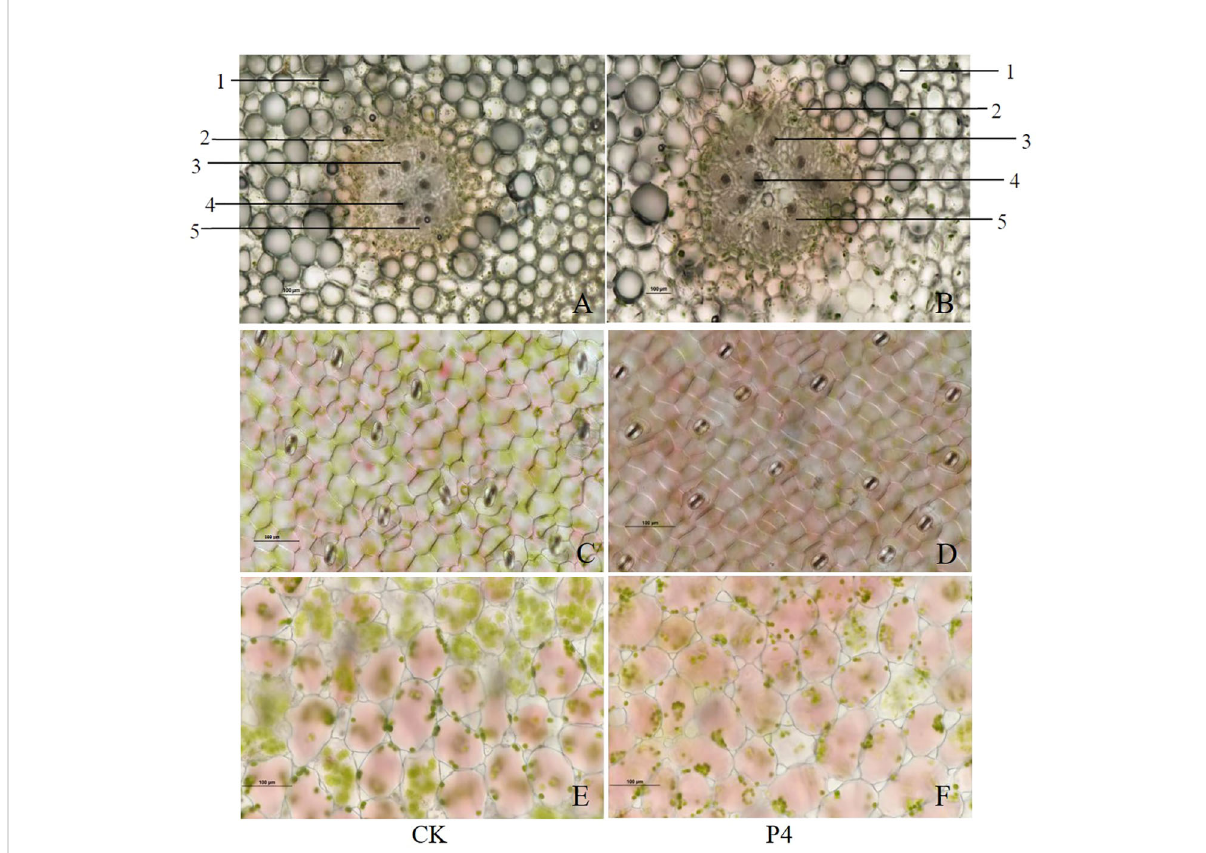
FIGURE 2 Morphological characteristics of stem (A, B) , anatomical structure of lower epidermis (C, D) , and mesophyll cells (E, F) in the leaf of A. roxburghii . (A, C, E) represented A. roxburghii in CK treatment; (B, D, F) represented A. roxburghii in P4 inoculation. 1 represents cortex, 2 represents endodermis, 3 represents phloem, 4 represents xylem, and 5 represents